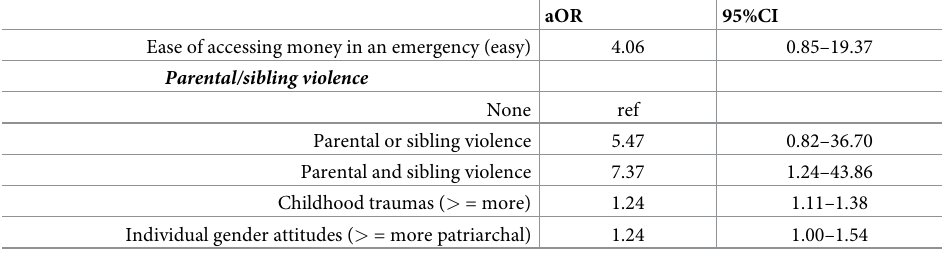
Table 4. Factors associated with ‘honour killing’ in the family amongst unmarried women in Afghanistan (n =